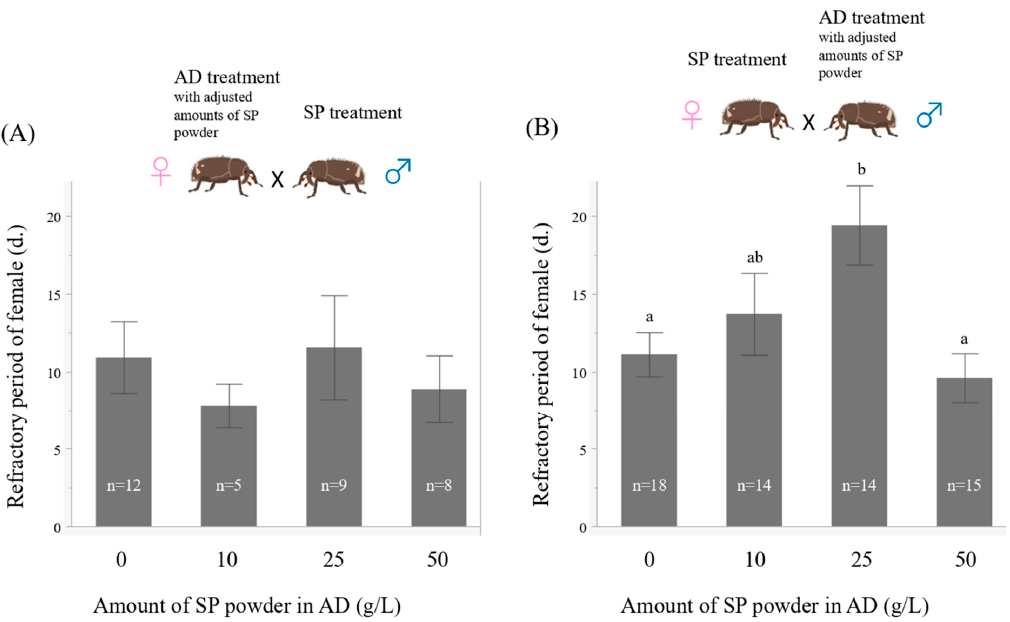
Figure 6. Relationship between the amount of sweet potato powder and the length of the refractory period of females (days; mean ± S.E.). ( A ) refractory period of females, obtained from AD treatment with adjusted amounts of SP powder, mated with males of SP treatment. ( B ) refractory period of females of SP treatment mated with males obtained from AD treatment with adjusted amounts of SP powder. Different letters show significant differences ( p < 0.05).